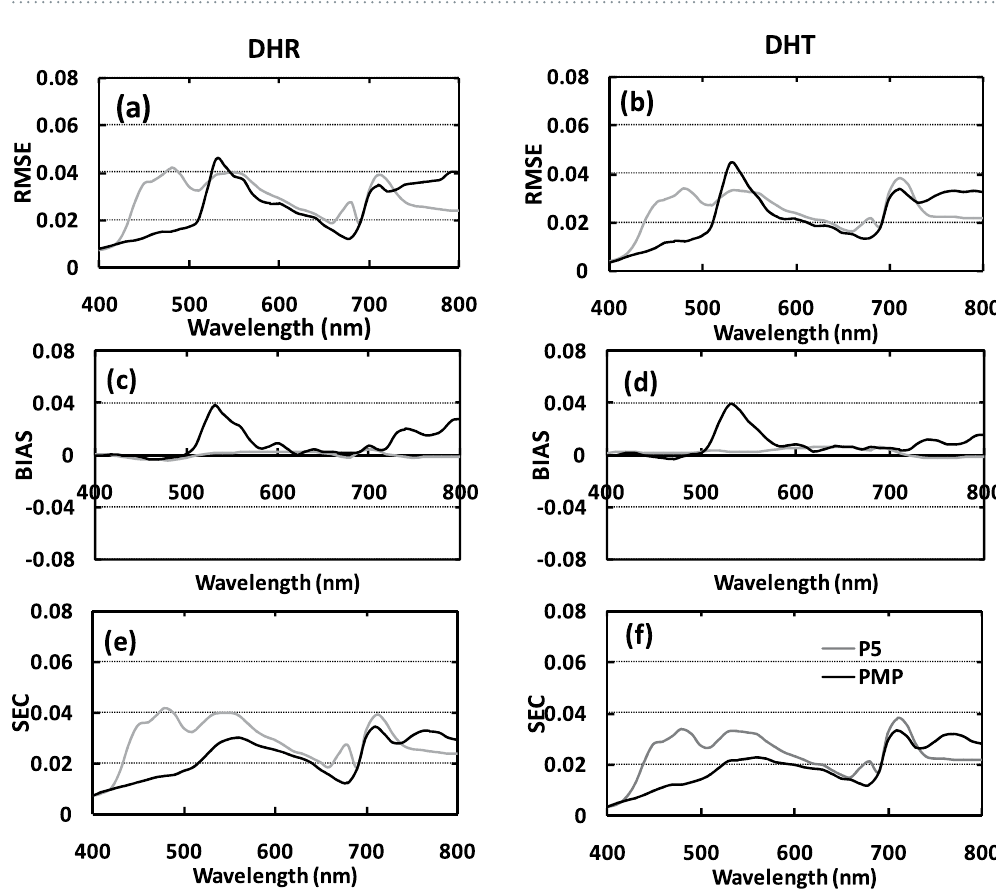
Figure 4. Simulated DHR (left column) and DHT (right column) spectra from P5 (grey line) and PMP (black line) (n = 32). ( a ) and ( b ) show RMSE values; ( c ) and ( d ) show BIAS; ( e ) and ( f ) show